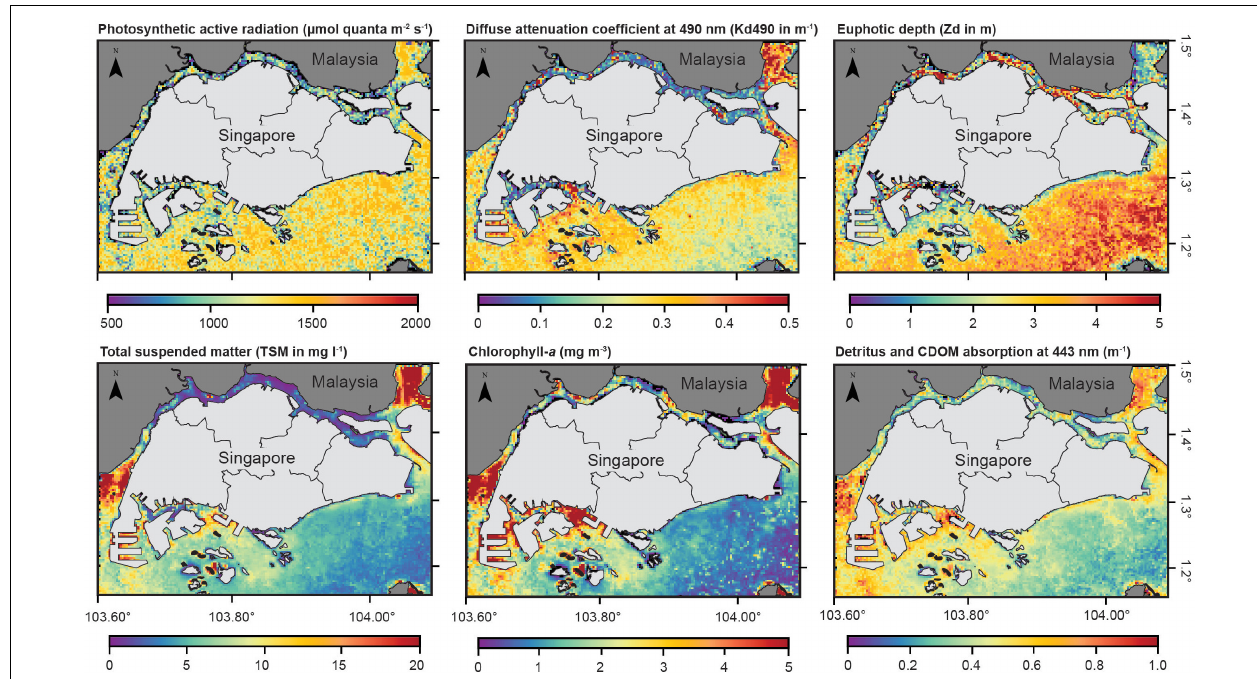
FIGURE 7 | Monthly (August 2018) averaged satellite-derived (Sentinel-3) maps of seawater optical properties across southern Singapore. Maps show spatial patterns in light: photosynthetic active radiation (PAR in µ mol quanta m − 2 s − 1 ), light attenuation coefficient (Kd 490 in m − 1 ), euphotic depth (m); and the constituents of seawater turbidity: chlorophyll- a (mg m − 3 ), total suspended matter concentration (TSM in mg l − 1 ), colored dissolved organic matter (CDOM) absorption at 443 nm (m − 1